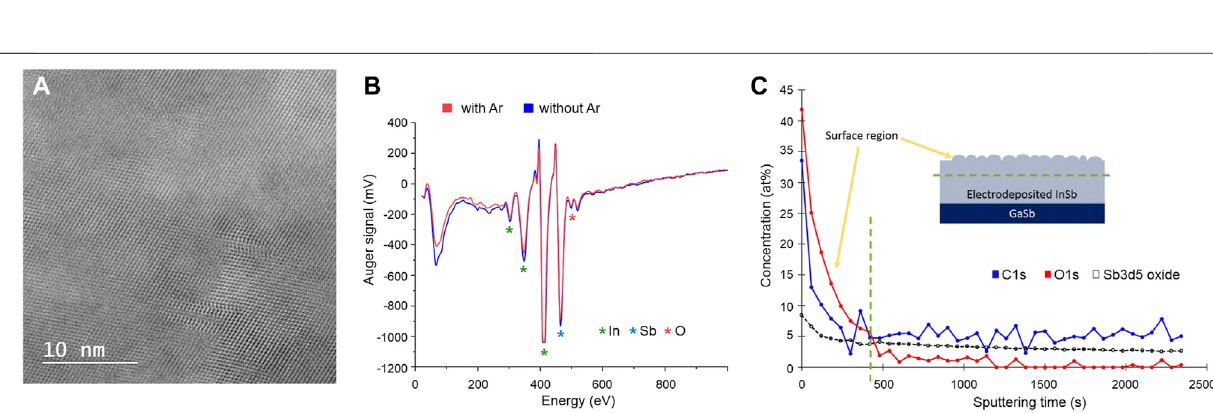
Frontiers in Chemistry |